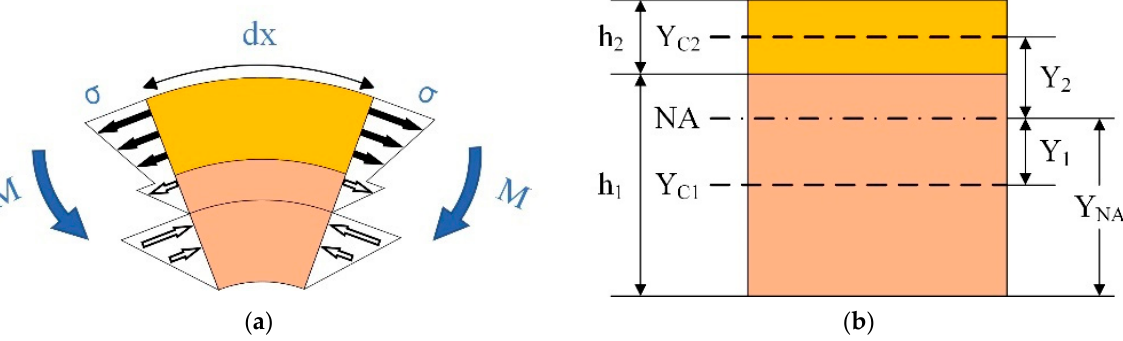
Figure 3. Schematic diagram of moment of inertia: ( a ) stress discontinuity in the bilayer film; ( b ) the neutral axis of the bilayer film.